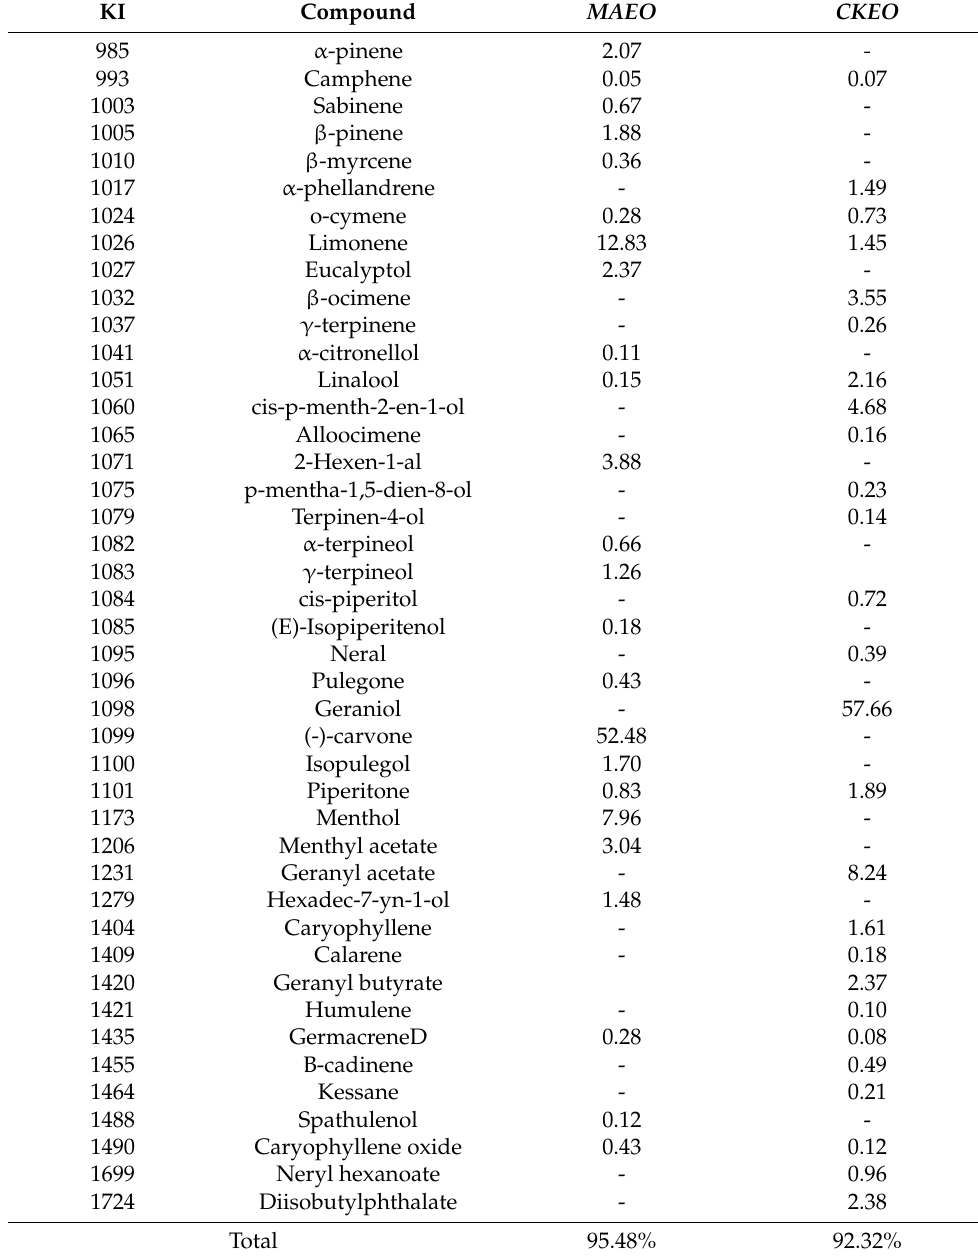
Table 1. Chemical composition of essential oils obtained from fresh leaves of